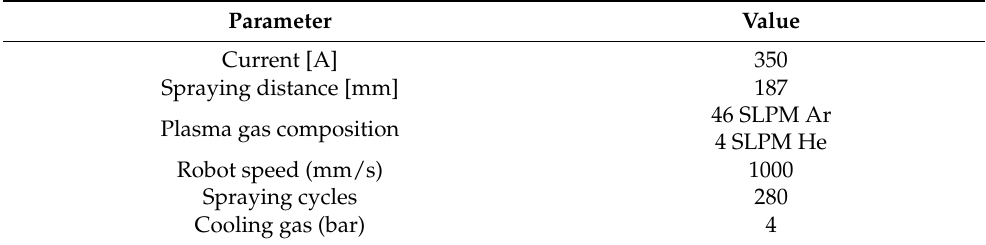
Table 1. Detailed spraying parameters of the plasma-sprayed YSZ coating.